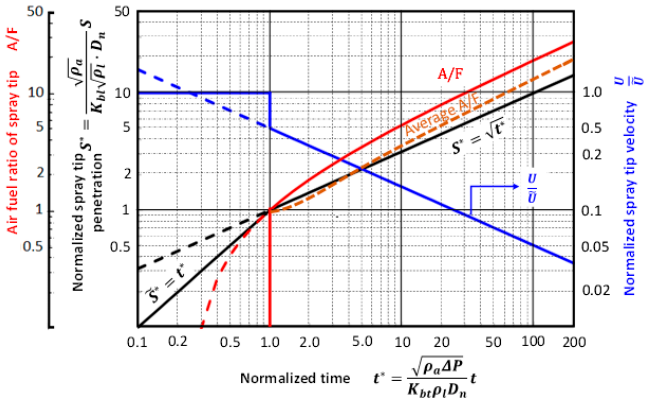
Figure 6. Normalized penetration, normalized velocity, and air/fuel ratio of spray tip. Further, the average A / F of a whole spray after breakup to injection end can be expressed by the following equations under an assumption of constant injection rate. It can be obtained by an integration of whole local A / F that is represented by tip A / F during the development process of spray from t * = 1 to t * = t * .